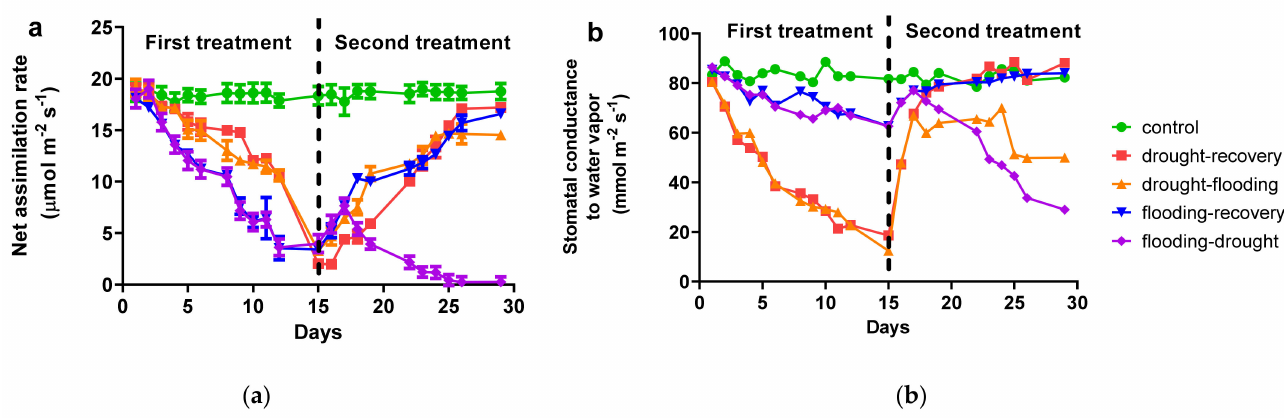
Figure 2. The net assimilation rate ( a ) and stomatal conductance to water vapor ( b ) from O. basilicum plants under different stress conditions. The values are averages of three independent